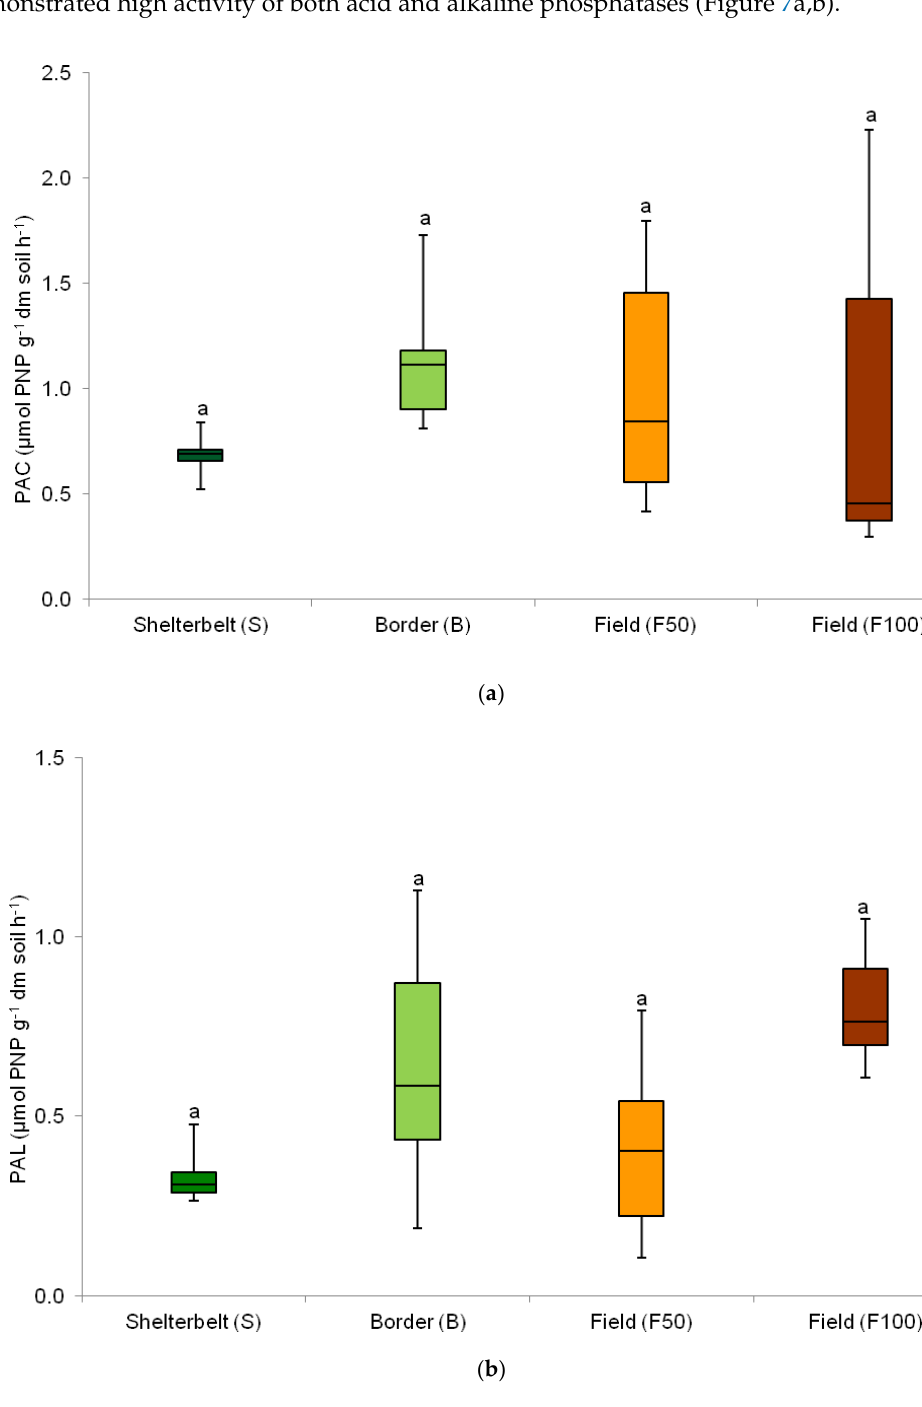
Figure 7. Box plots and results of one-way ANOVA showing the effect of soil use on PAC ( a ) and PAL ( b ) activity level along the measurement transect. The top hanging bar represents the high edge, and the lower hanging bar is the lower edge; − median; (cid:3) quartile 25–75%; significant di ff erence at p < 0.05; n = 9; the same letters indicate no statistical di ff